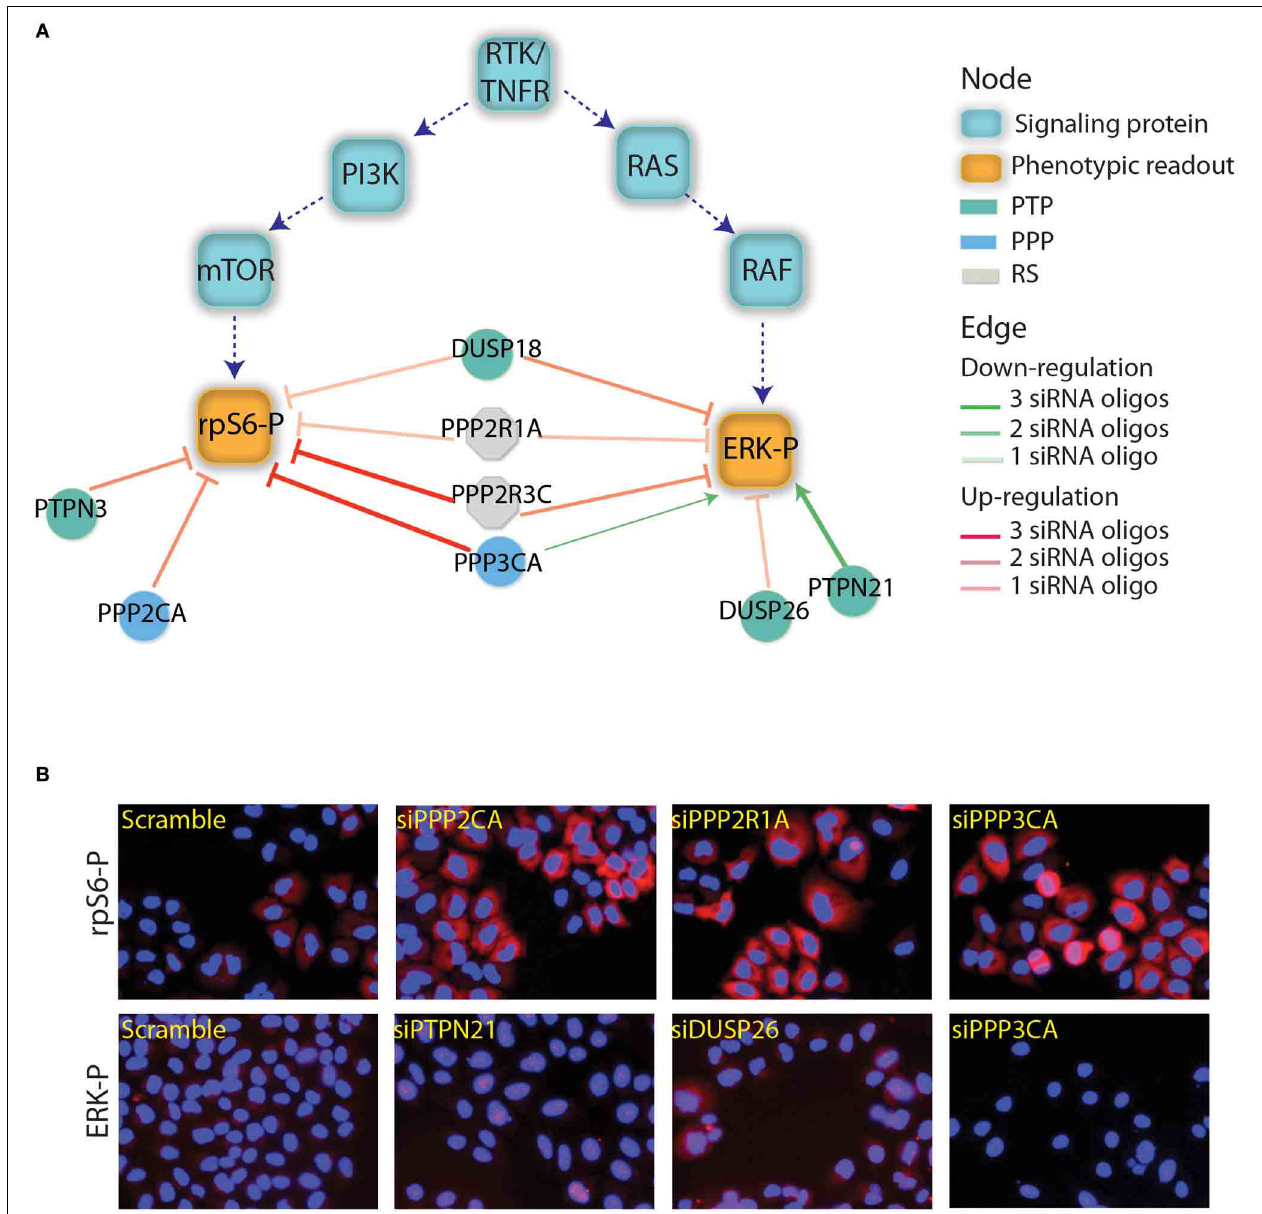
FIGURE 1 | Phosphatases affecting the RAS-PI3K pathway. (A) The results depicted in this figure are a subset of the results reported by Sacco et al. (2012a). The squares represents the main proteins that are involved in the PI3K and RTK/RAS signaling cascades. Green squares are the phosphorylated proteins that have been used as readouts in the screening. The phosphatase whose down regulation was shown to affect the readouts are represented as circles and are linked to readouts with red or green edges depending on whether their down-regulation negatively or positively affected